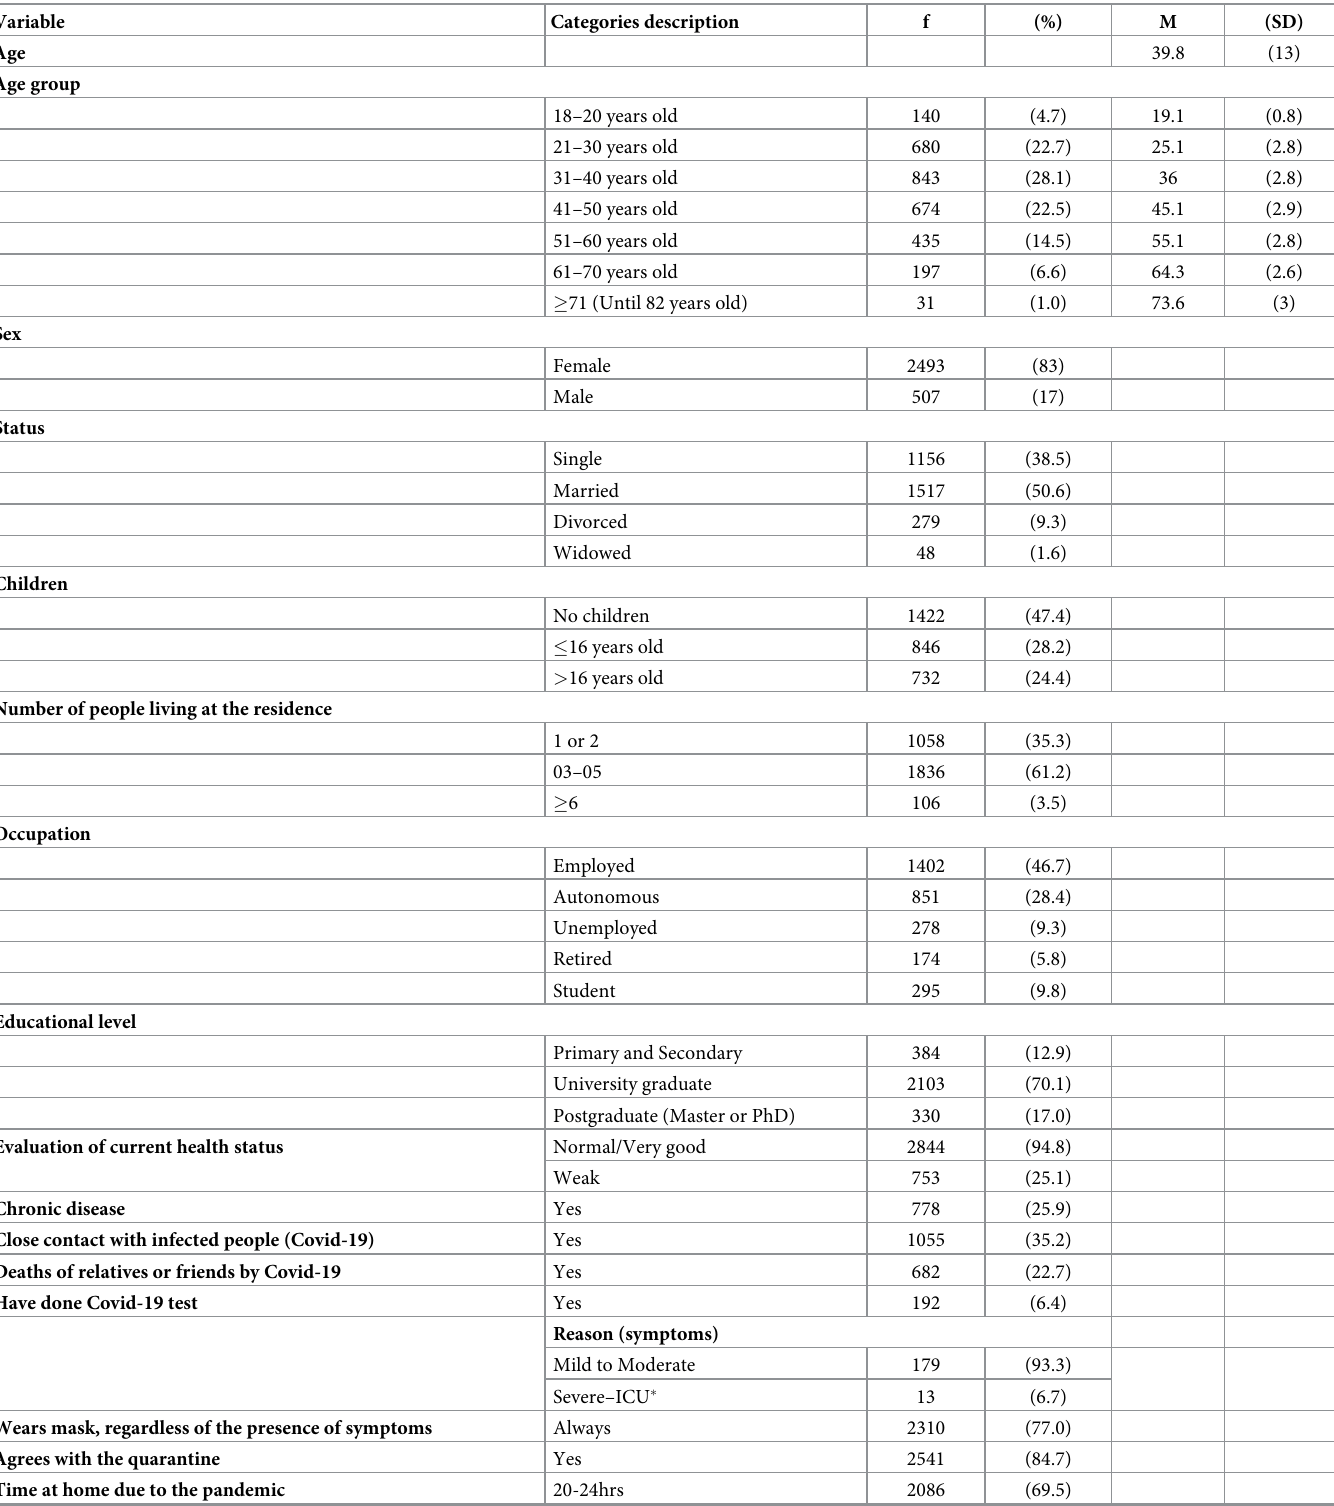
Table 1. Sociodemographic and behavioral characteristics during the quarantine (N =